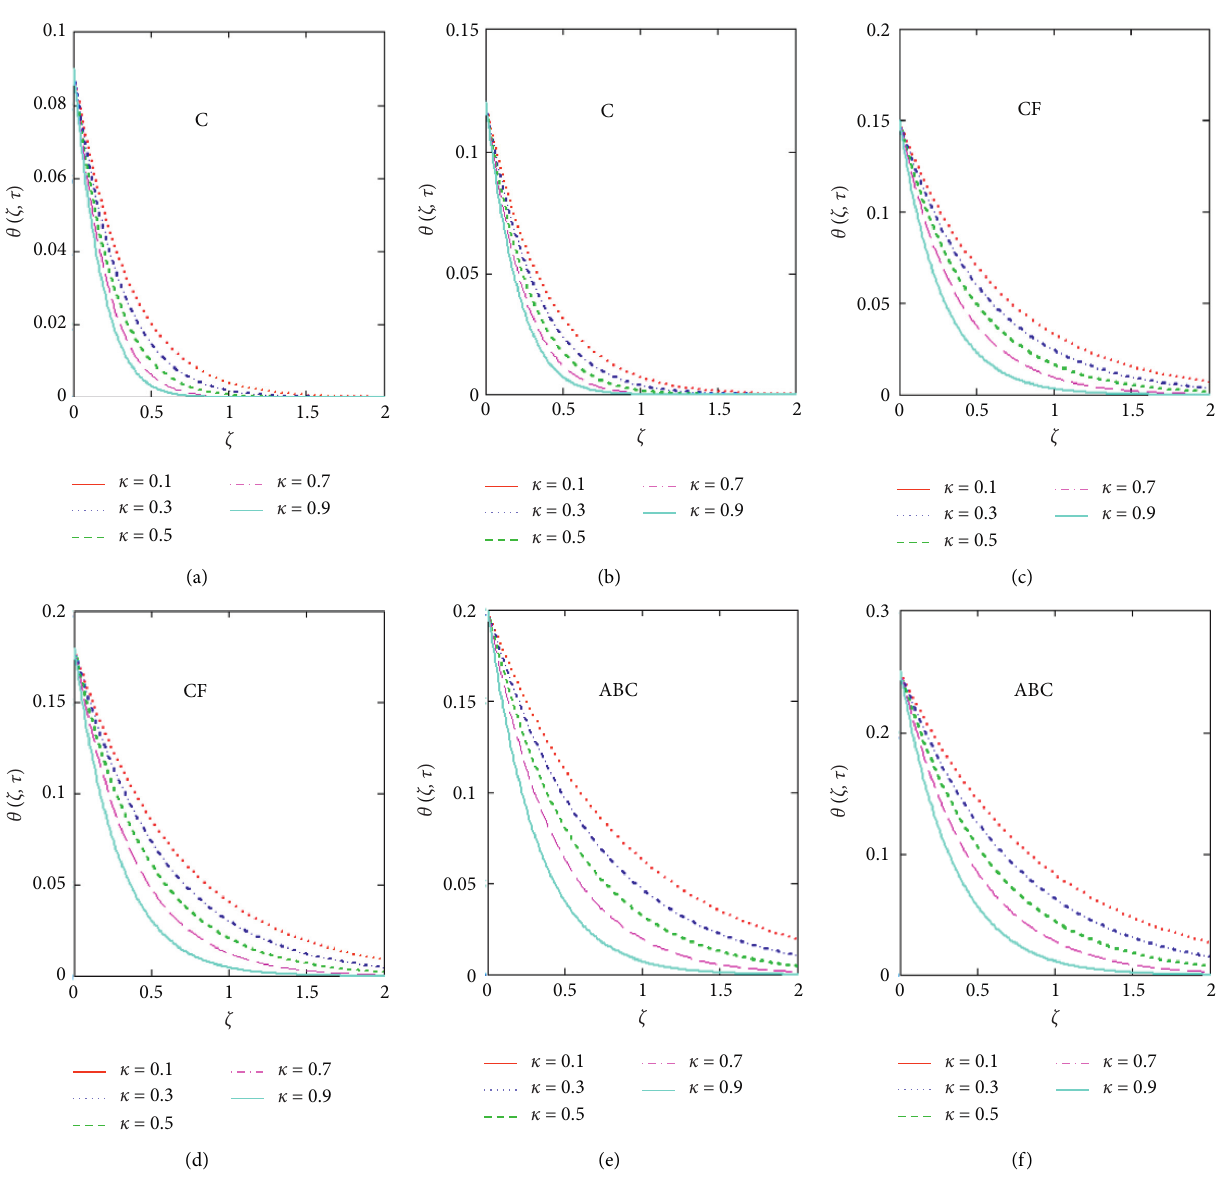
Effect of κ : Figure 9 highlights the effect of the fractional